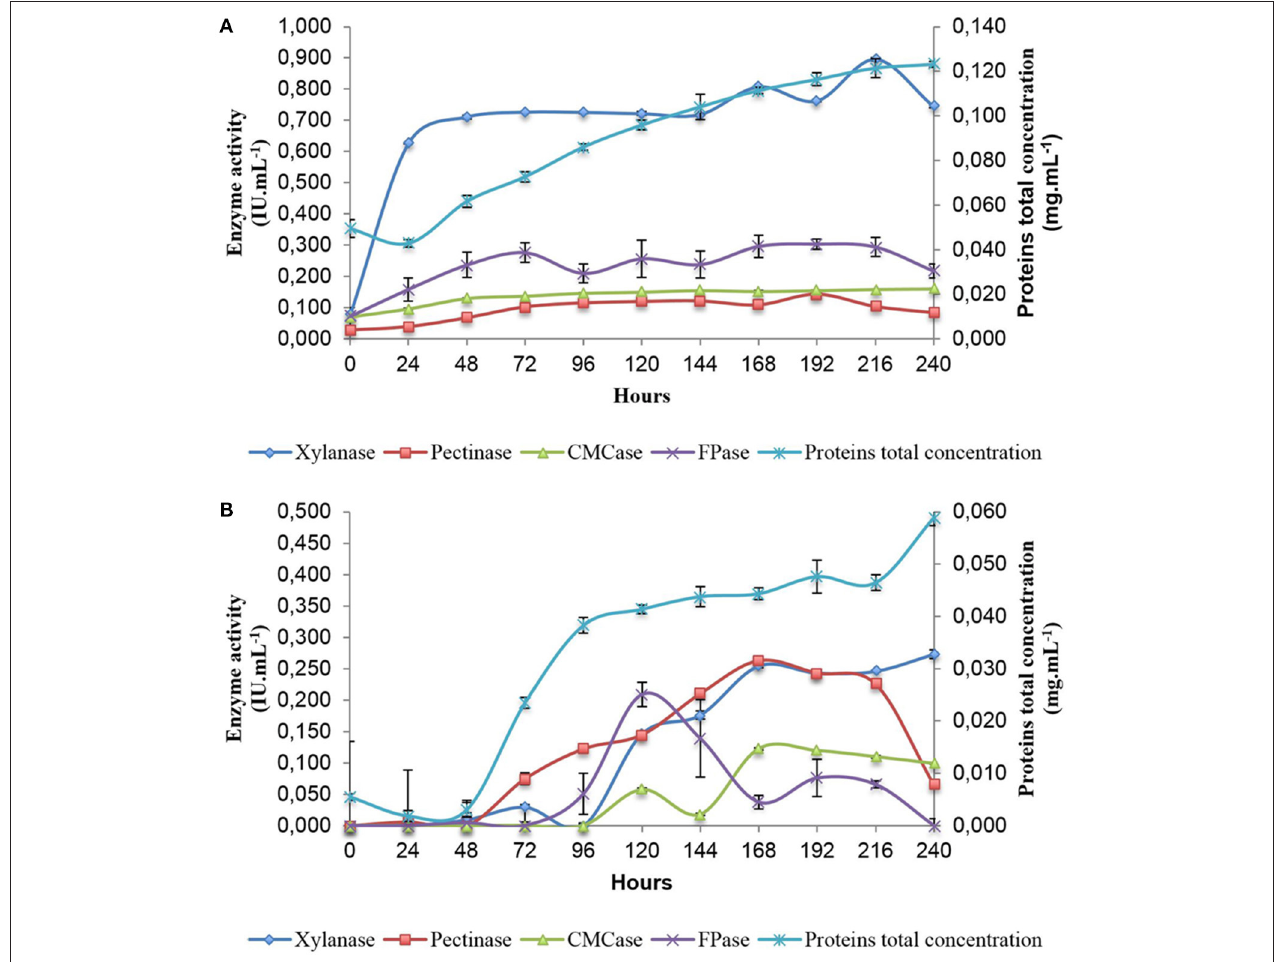
FIGURE 2 | Enzymatic activity profile of A. tamarii BLU37 in response to xylan, pectin, carboxymethylcellulose and filter paper substrates following growth in liquid minimal medium supplemented with sugarcane (1% w/v ) (A) or glucose (1% w/v ) (B) as carbon source. Activities were determined through a DNS assay at pH 5.0.